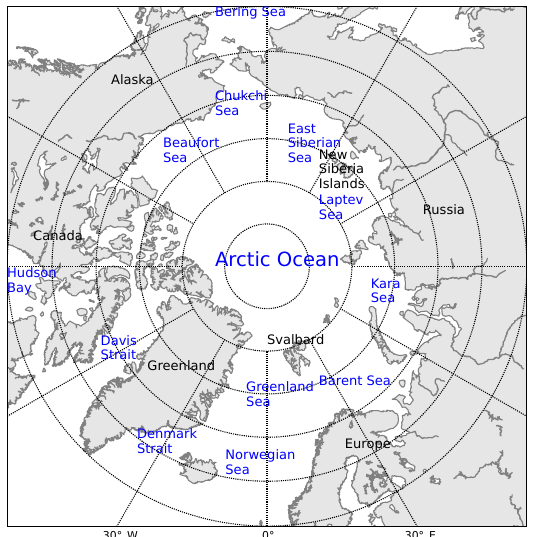
Figure A1. The Arctic Ocean and regional seas are labelled in blue, land masses in